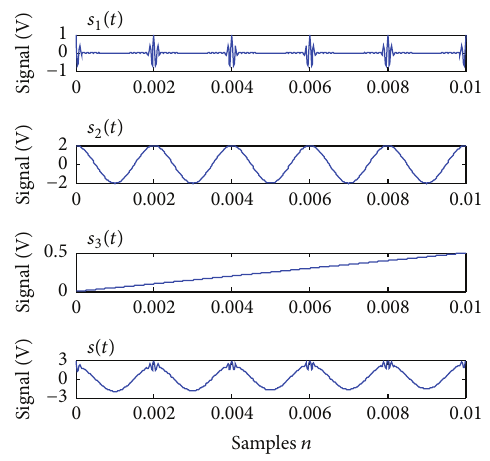
Figure 1: The simulated